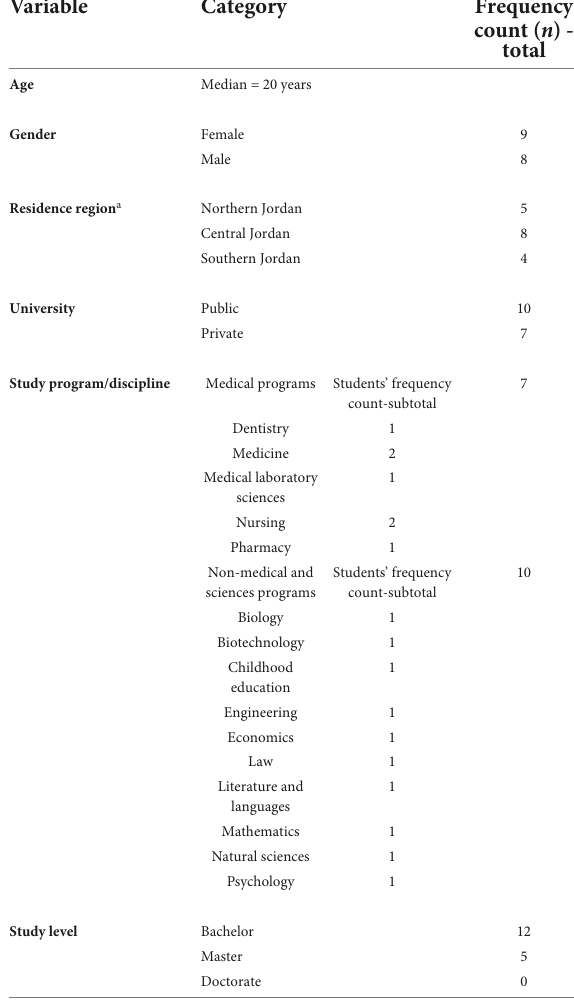
TABLE 1 Participants’ characteristics ( n =